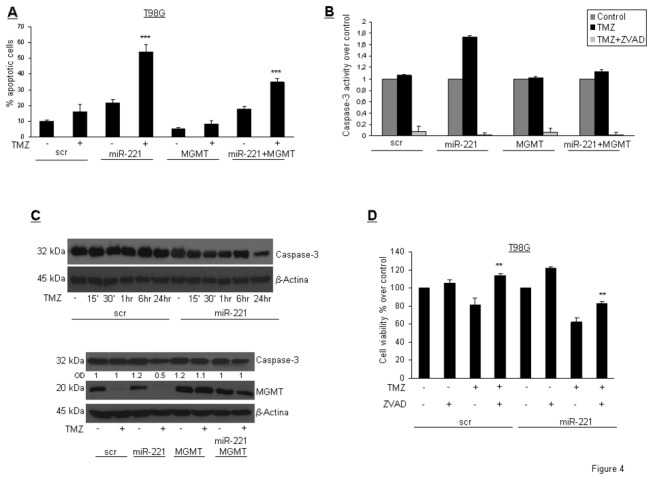
miR-221 promotes DNA damages upon TMZ treatment.(A) Apoptotic cell death assessed by FACS in T98G cells transfected with miR-221 or scrambled sequence and MGMT and treated with TMZ for 24 hrs. *** p value< 0.005 versus untrasfected MGMT column. (B) Active caspase-3 quantification in T98G cells as indicated and treated with TMZ for 24 hrs in the presence or absence of 3 hrs pre-treatment with ZVAD-fmk. (C) Upper panel Time course analysis of caspase-3 activation upon TMZ treatment in T98G cells transfected with miR-221 or with scrambled sequence. Lower panel Western blot analysis of caspase-3 activation after miR-221 and MGMT transfection. (D) Cell viability of T98G cells transfected with miR-221 or with scrambled sequence treated with TMZ for 24 hrs in the presence or absence of 3 hrs pre-treatment with ZVAD-fmk. ** p value< 0.0034 versus only treated TMZ column, Student’s t test.